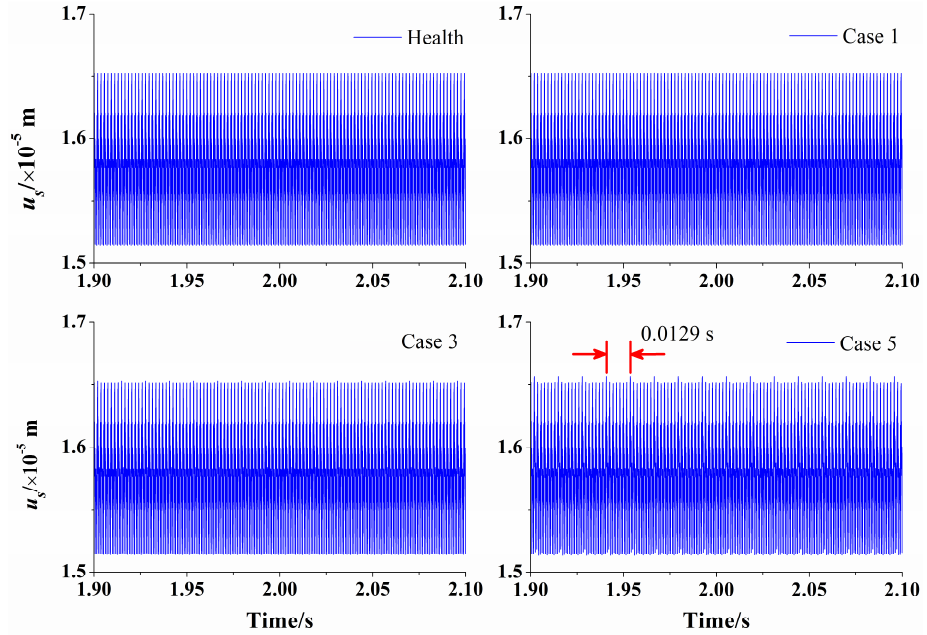
Figure 17. Time histories of torsional vibration responses on the sun gear.